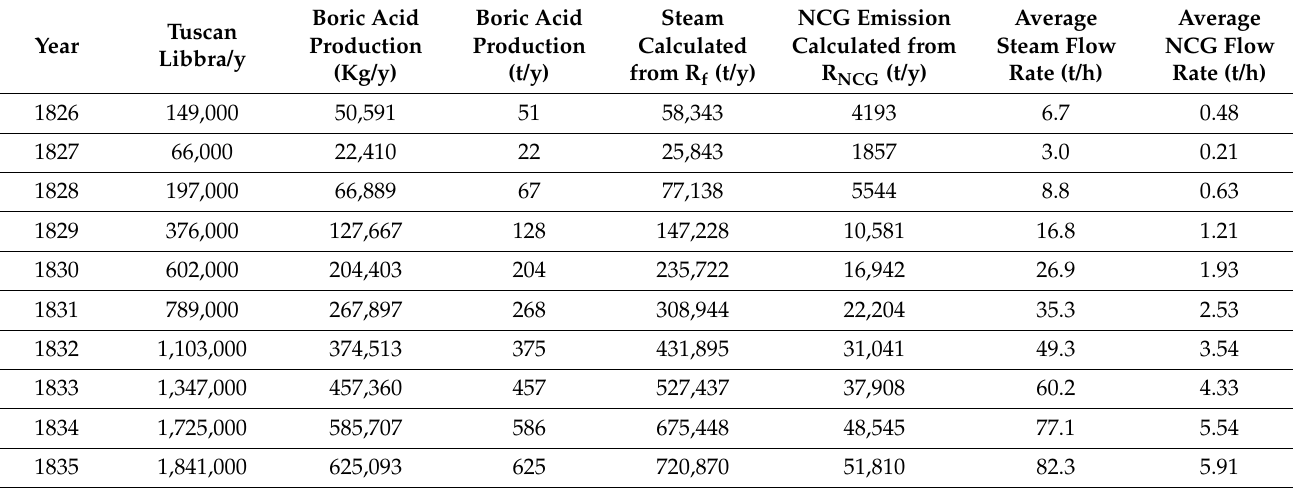
Table 4. Calculated steam flow rates and NCG flow rates from boric acid production data according to ref.